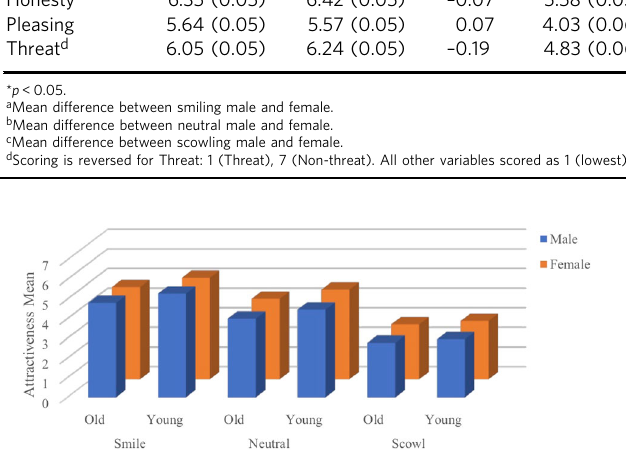
Fig. 5 Facial expression and Honesty. This graph presents interaction of facial expression, age, and gender on mean ratings of Honesty.